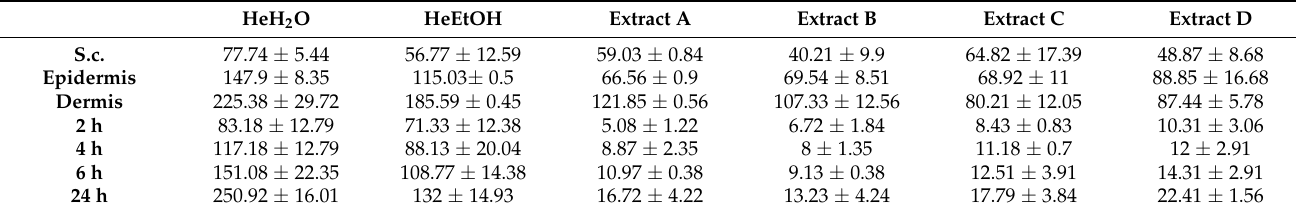
Table 2. Accumulation of hesperidin analysed by HPLC-UV and HPLC-EC among skin layers: stratum corneum, epidermis, and dermis, and hesperidin permeation through the skin after 2, 4, 6, and 24 h (ng/cm 2 ) from the application of hesperidin solutions (HeH 2 O, HeEtOH) or honeybush extracts (A, B, C, D). HeH 2 O HeEtOH Extract A Extract B Extract C Extract D HeH 2 O HeEtOH Extract A Extract B Extract C Extract D S.c. 77.74 ± 5.44 56.77 ± 12.59 59.03 ± 0.84 Epidermis 147.9 ± 8.35 115.03± 0.5 66.56 ± 0.9 S.c. 225.38 ± 29.72